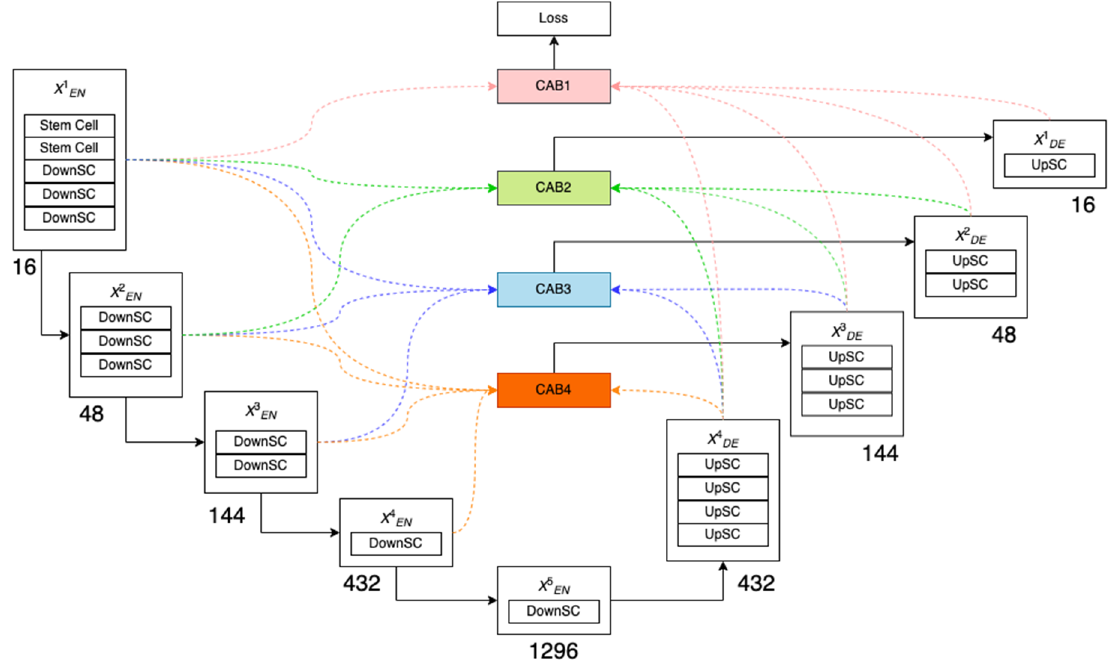
Figure 6. The proposed NAS-MACU architecture and cell topology at the high level. DownSC (down-sampling cell) and UpSC (up-sampling cell) cells are stacked into the MACU network.